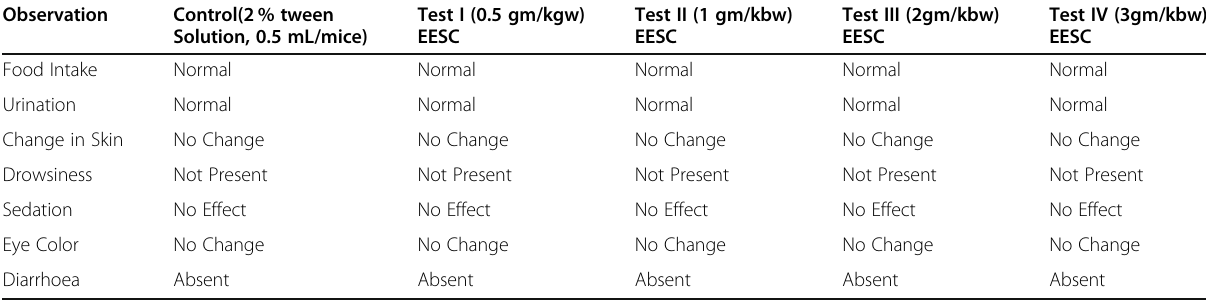
Table 2 Effect of ethanolic extract of S. caseolaris (L.) Engl. fruit on behavioral aspects